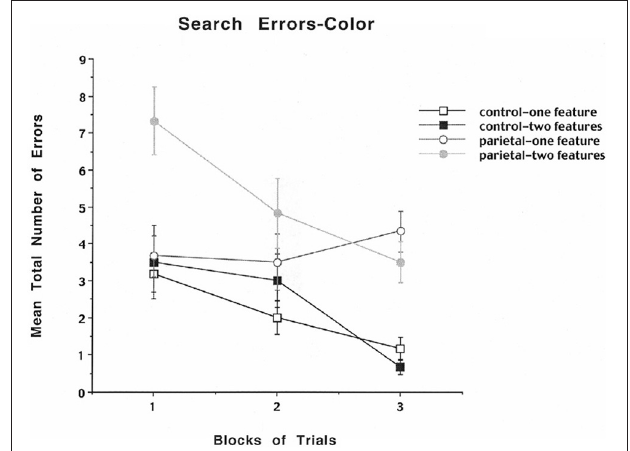
FIGURE 3 | Mean number of search errors for one or two features for object color for control and parietal cortex lesioned rats as a function of blocks of trials. Each block consisted of 20